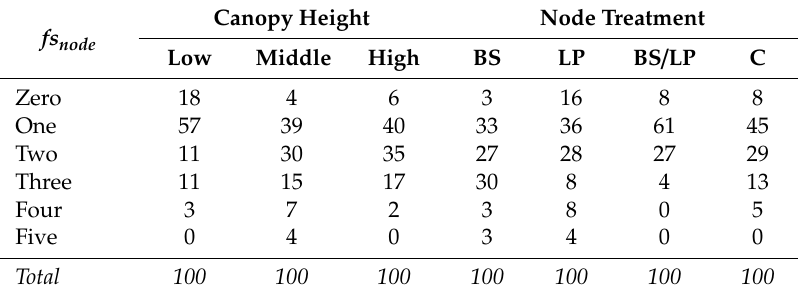
Table 3. The percentage of floral nodes that set zero, one, two, three, four, or five fruit ( fs node ) for each canopy height (low, middle, high) and for each node treatment (BS = bud shading; LP = leaf pluck; BS / LP = bud shading plus leaf pluck; C = control). Pearson’s chi-square test with canopy height, X 2 (10, N = 122) = 14.752, p = 0.141. Pearson’s chi-square test with node treatment, X 2 (15, N = 122) = 18.885, p = 0.219. fs